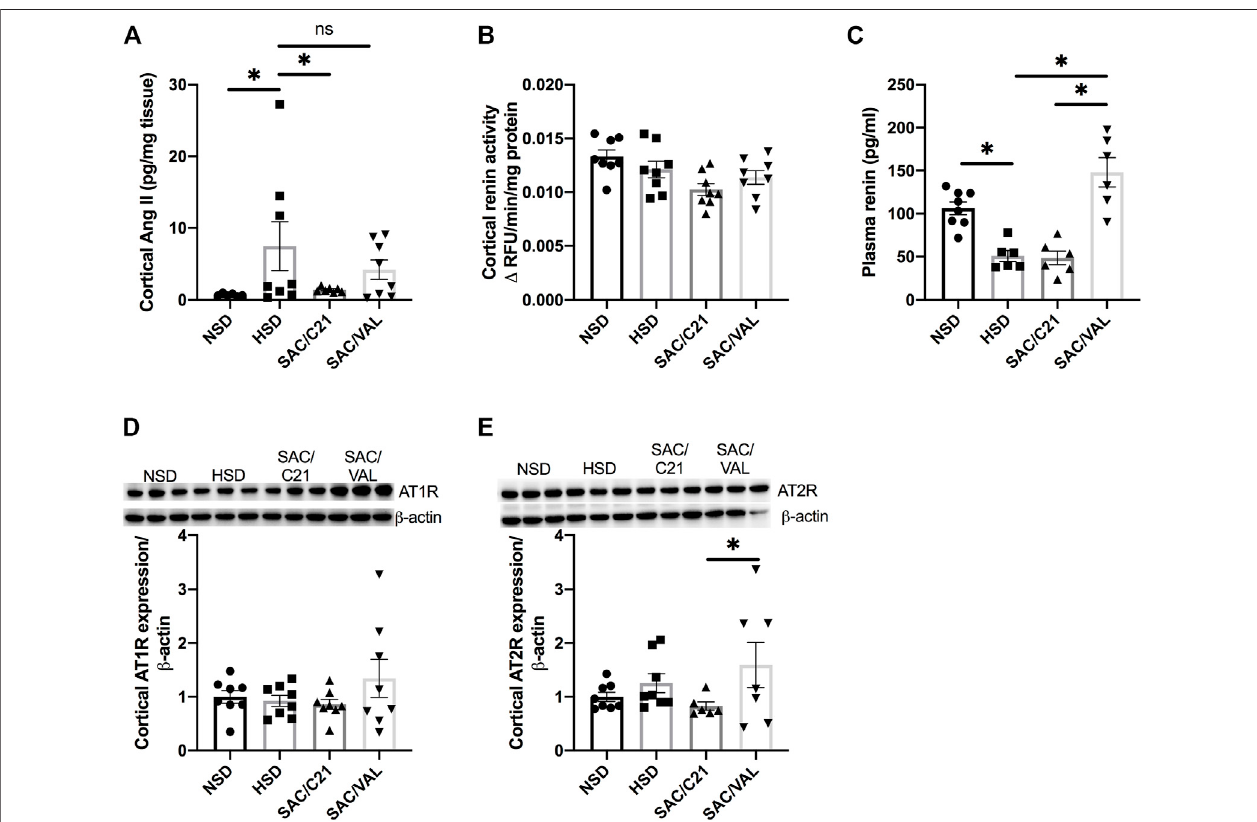
FIGURE4| Angiotensin peptides, receptors and downstreamsignaling markersinobese Zuckerrats onNSD orHSDand treated withvehicle, SAC/C21, orSAC/ VAL. (A) corticalAngII, (B) reninactivityinkidneycortex, (C) plasmarenin, (D) AT 1 Rexpressioninkidneycortex, (E) AT 2 RexpressioninkidneycortexfromobeseZucker ratsonNSDorHSDandtreatedwithvehicle,SAC/C21,orSAC/VAL.Datashownasmean ± SEM,analyzedbyone-wayANOVA,followedbyFisher ’ sLSDtest.Results are considered signi fi cant at * p < 0.05, with a 95% con fi dence interval; n (cid:1) 6 – 8 for Ang II, plasma renin and AT 2 R expression and n (cid:1) 8 renin activity and AT 1 R expression. NSD — normal salt diet fed + vehicle treated obese control, HSD — high salt diet fed + vehicle treated obese control, SAC/C21 — high salt diet fed obese rat treated with sacubitril + C21, SAC/VAL — high salt diet fed obese rat treated with sacubitril + valsartan.